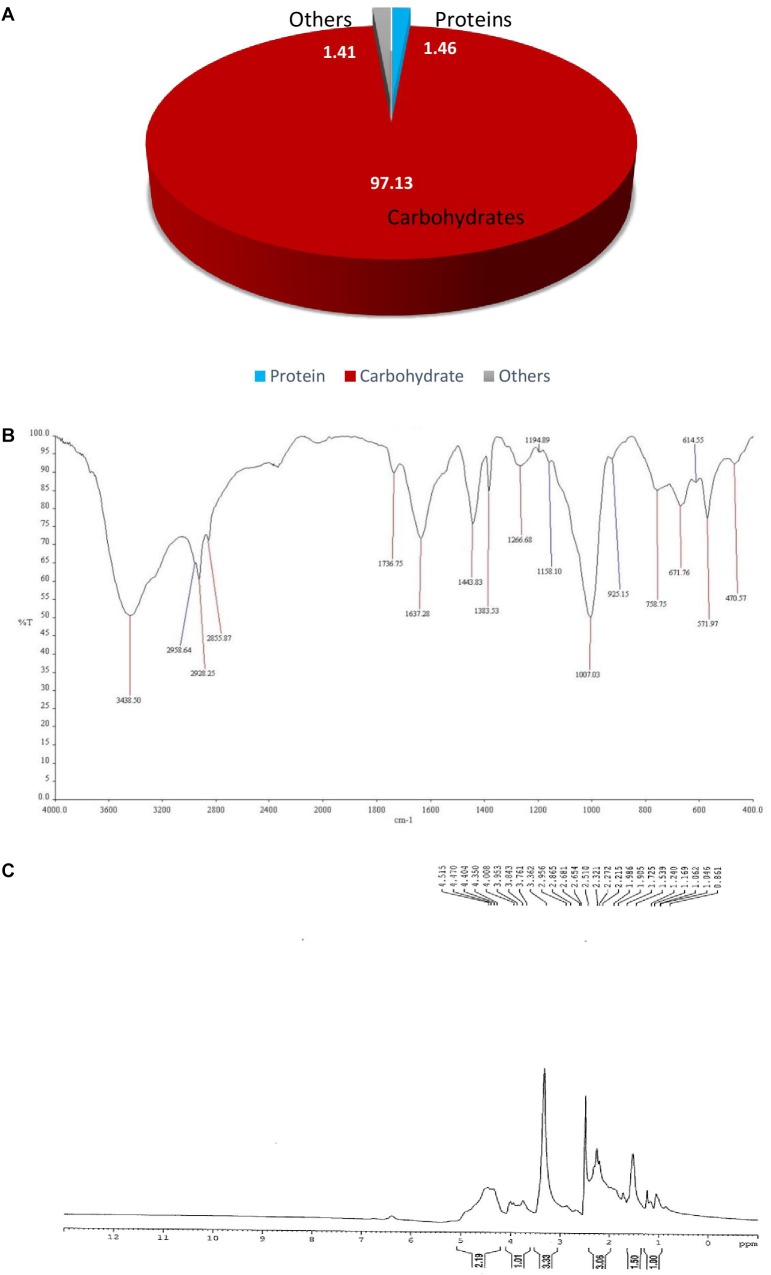
Characterization of purified bioflocculant BF-VB2. (A) Chemical composition; (B) FT-IR spectra depicting the functional groups; and (C) NMR spectra (1H).